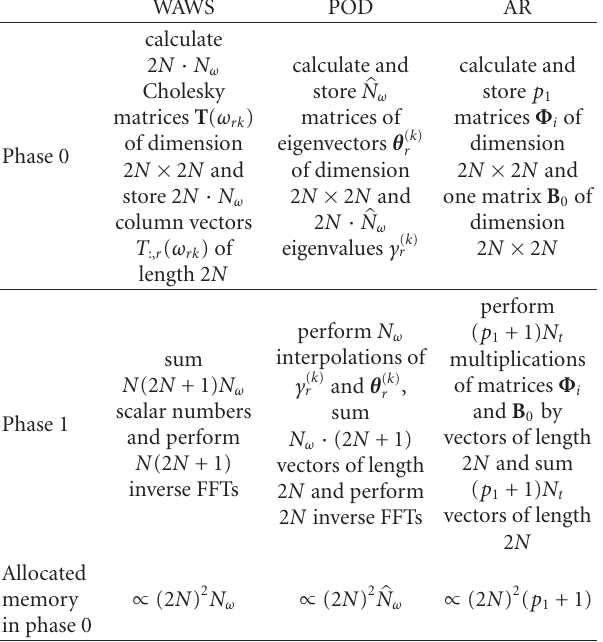
Table 3: Computational e ff orts required by the three di ff erent methods for digital wind simulation ( T 0 and T sim denote the computer times necessary for performing the “phase 0” and one single simulation in the “phase 1”,